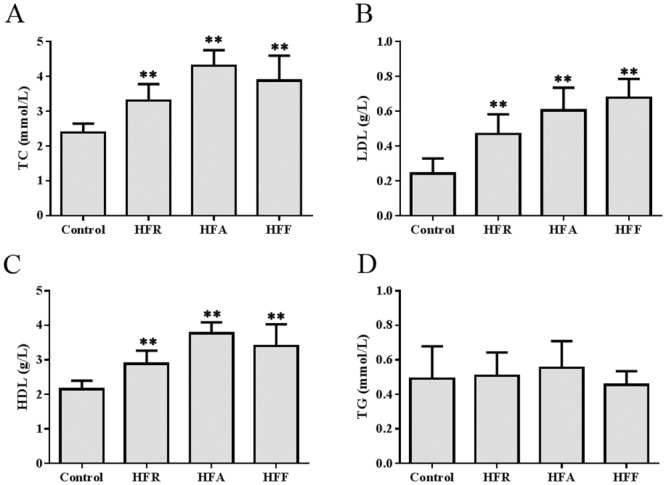
Effect of diet modification on lipid metabolism.The levels of total cholesterol (TC, A), low-density lipoprotein cholesterol (LDL, B), high-density lipoprotein cholesterol (HDL, C) and triglyceride (TG, D) were detected in the control, HFR, HFA and HFF groups. Data are presented as means ± SD (n ≥ 6 in each group). A significant difference was determined by one-way analysis of variance. *P < 0.05 versus control, **P < 0.01 versus control.